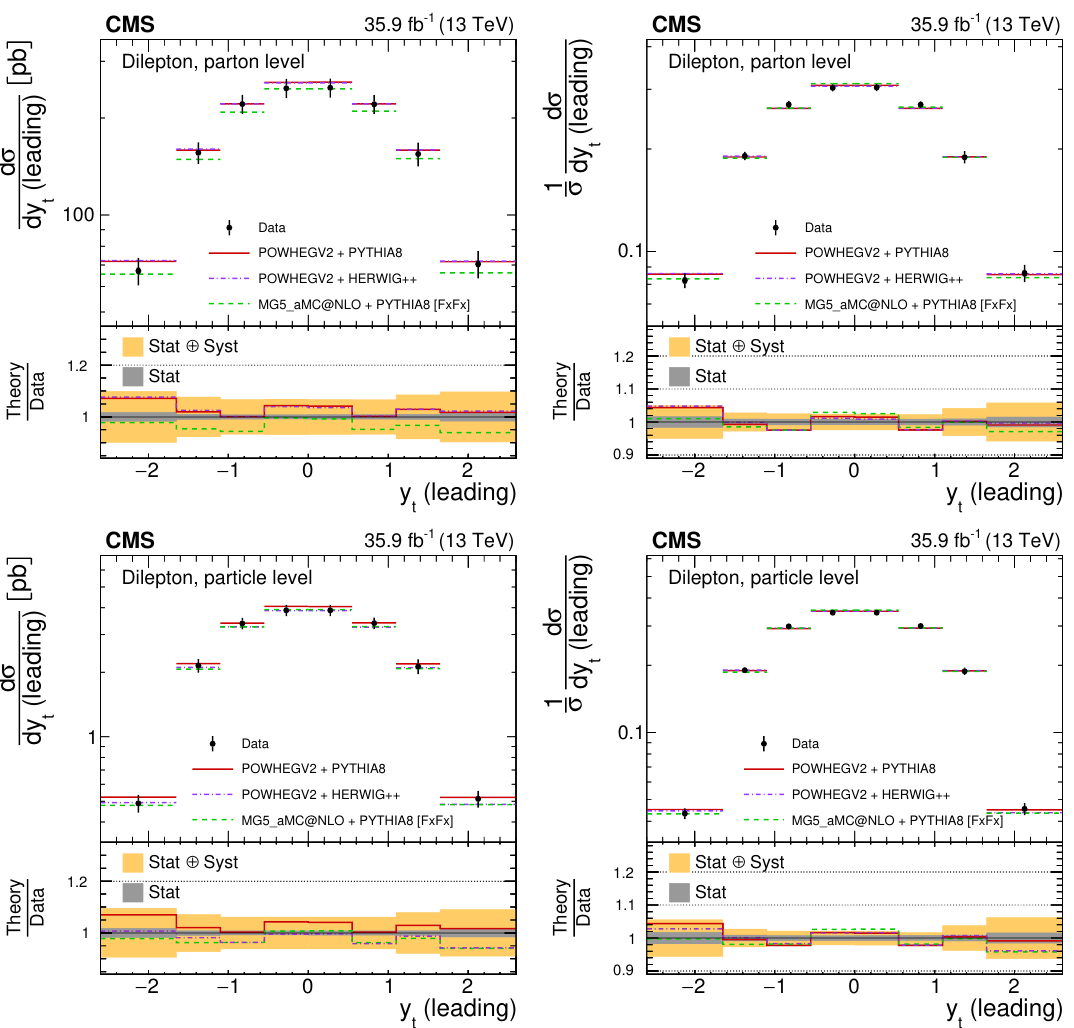
Figure 18 . The di(cid:11)erential tt production cross sections as a function of y t (leading) are shown for the data (points) and the MC predictions (lines). The vertical lines on the points indicate the total uncertainty in the data. The left and right columns correspond to absolute and normalised measurements, respectively. The upper row corresponds to measurements at the parton level in the full phase space and the lower row to the particle level in a (cid:12)ducial phase space. The lower panel in each plot shows the ratios of the theoretical predictions to the data. The dark and light bands show the relative statistical and total uncertainties in the data, respectively.